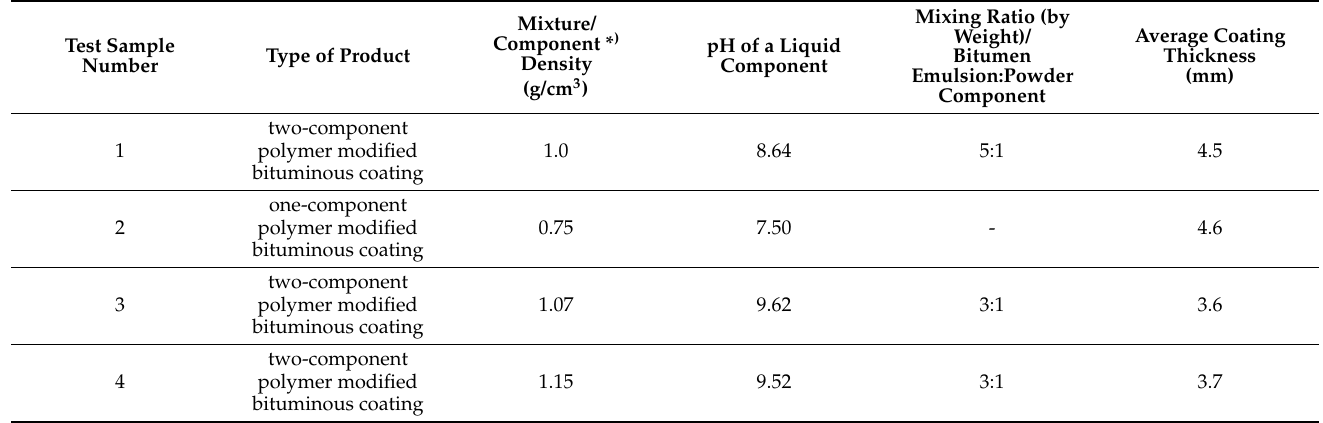
Table 1. Additional basic properties of the tested